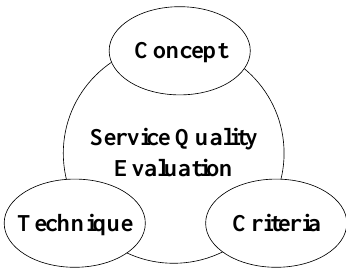
Figure 1: Main Parts of Service Quality Evaluation